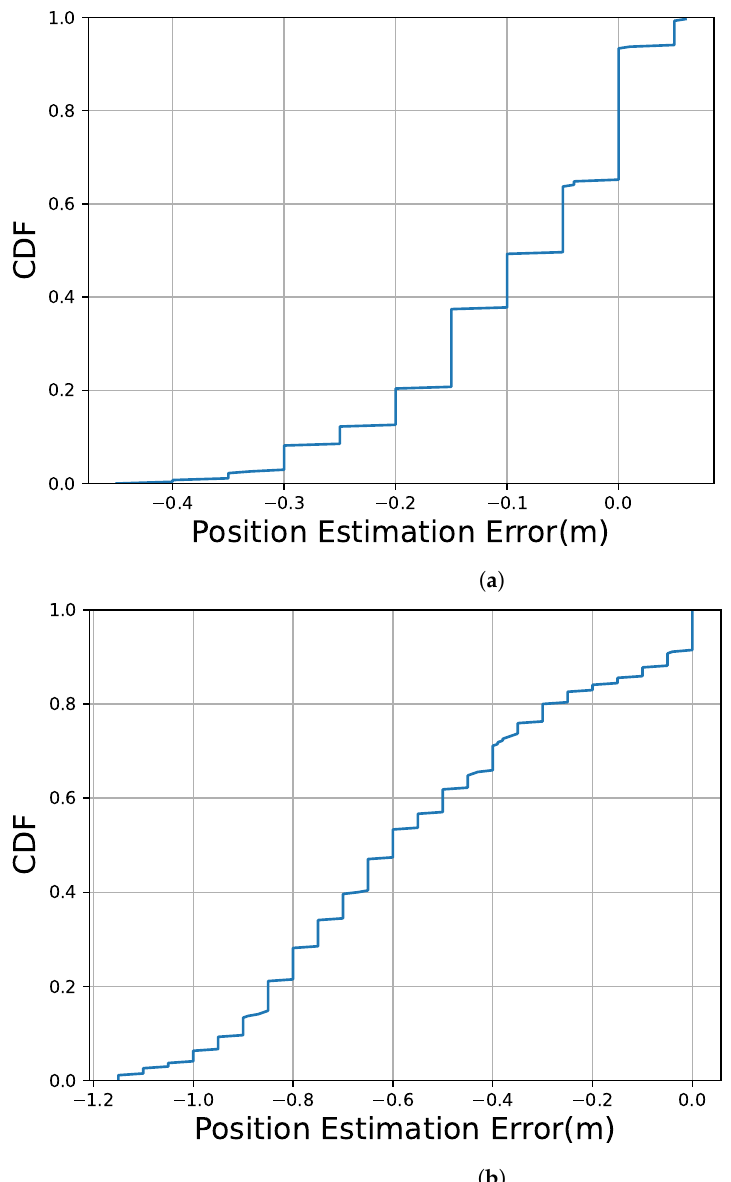
Figure 14. CDF of errors in the video frame’s estimated position. ( a ) Landmarks at 0 m, 1 m, 5 m, 7 m, and 8 m are used; ( b ) Landmarks at 0 m and 8 m are